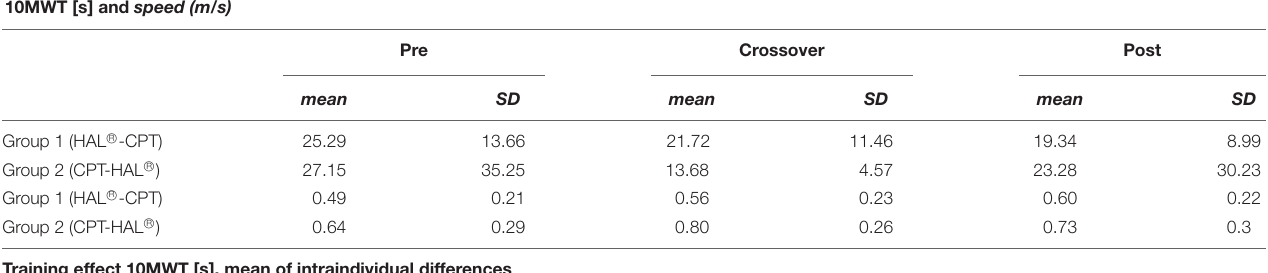
TABLE 3 | Data sheet with mean values for walking parameters, standard deviation and mean period